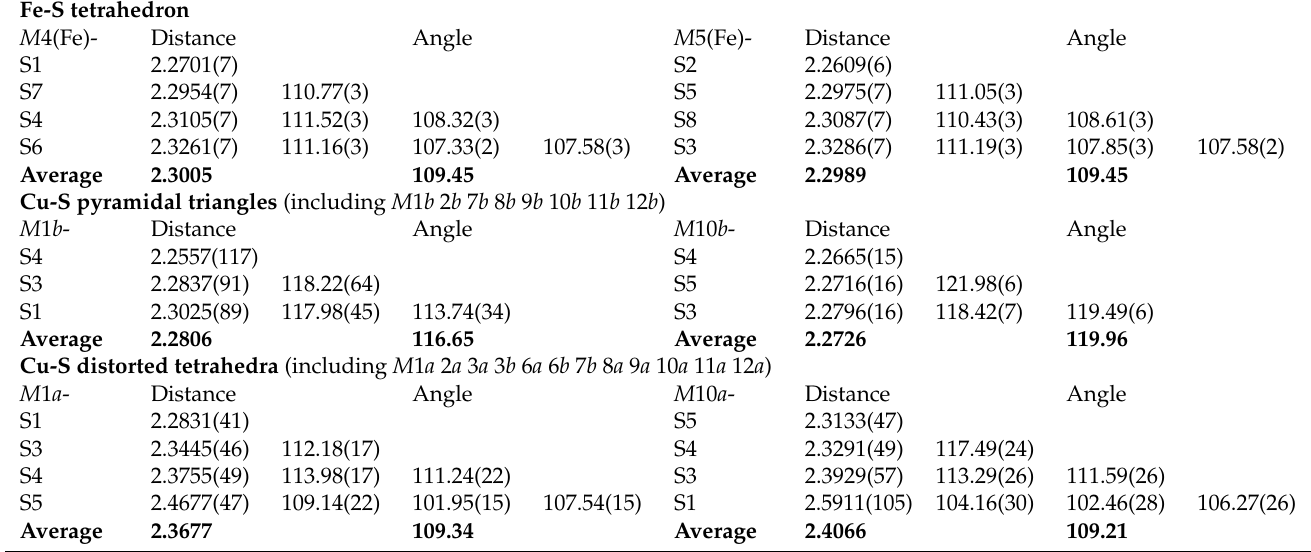
Table 4. Selected bond lengths and angles of